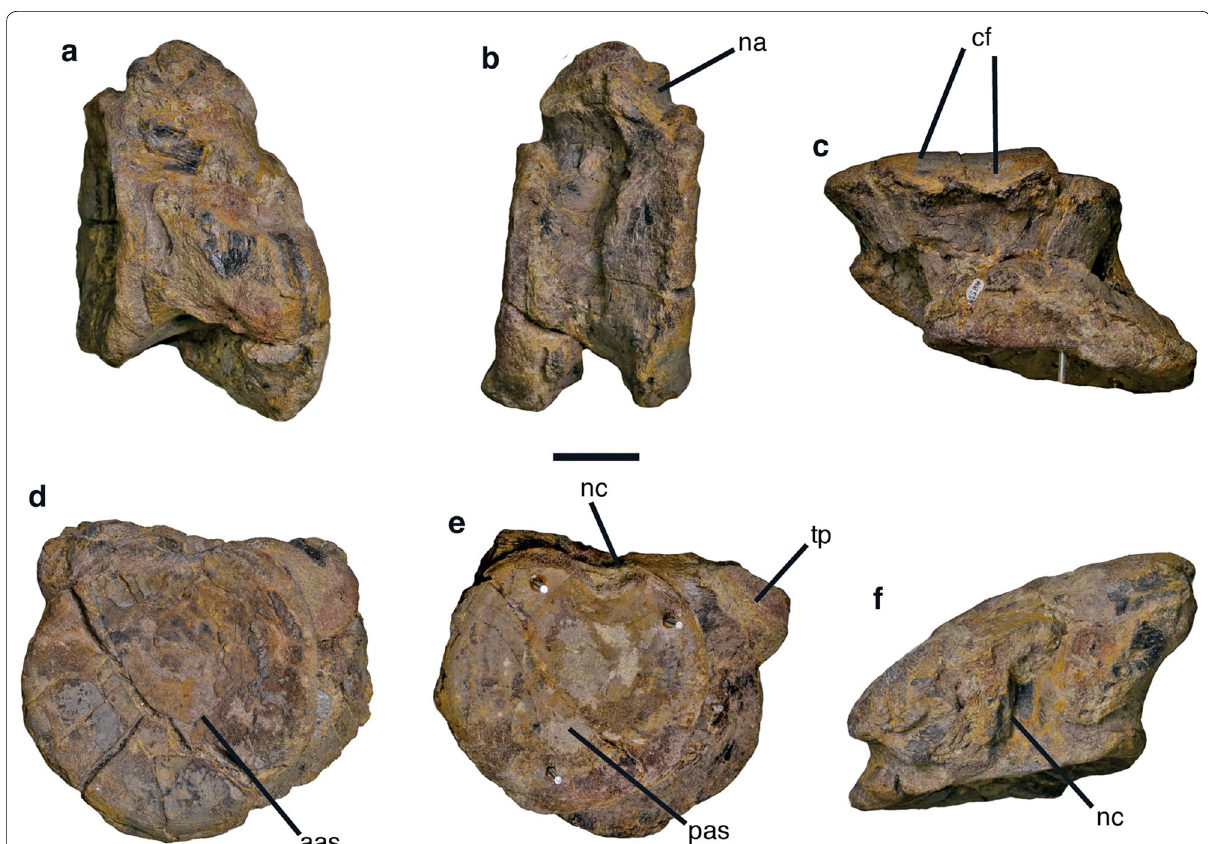
Fig. 6 Anterior caudal vertebra of Schleitheimia schutzi n. gen., n. sp., PIMUZ A/III 538. a , b right and left lateral view; c ventral view; d anterior view; e posterior view; f dorsal view. Abbreviations: aas, anterior articular surface; cf, chevron facet; na, neural arch; nc, neural canal; pas, posterior articular surface; tp, transverse process. Scale bar equals 5